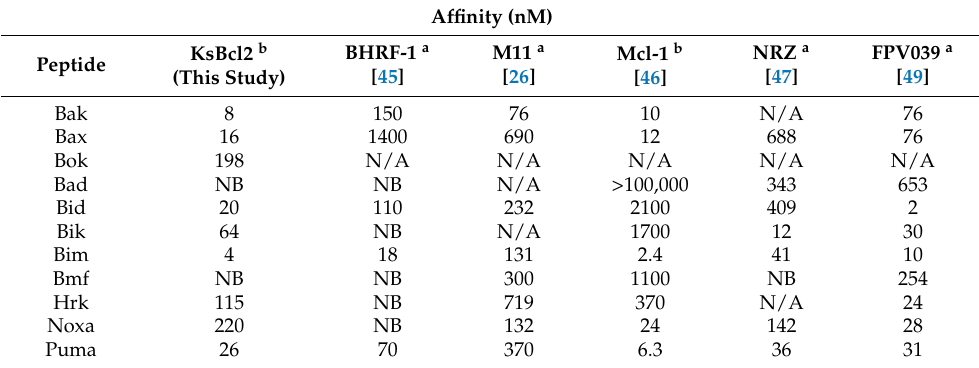
Table 3. Summary of pro-apoptotic BH3 motif affinities for KsBcl-2 and its closely related